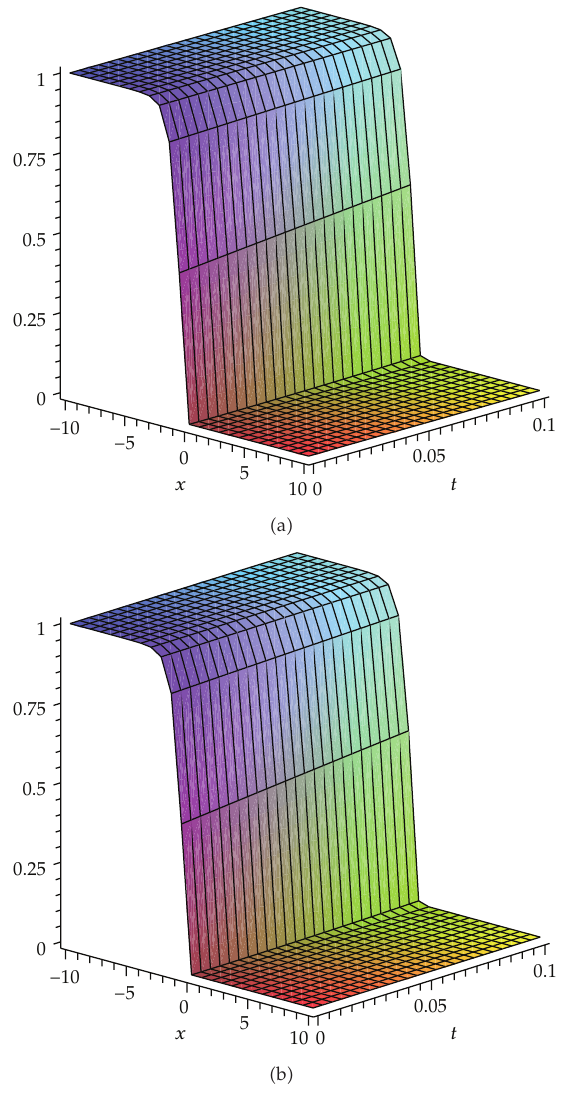
Figure 2: The solution of (cid:3) 1.1 (cid:4) at c (cid:9) 1 (cid:3) a (cid:4) HPM (cid:3) b (cid:4)